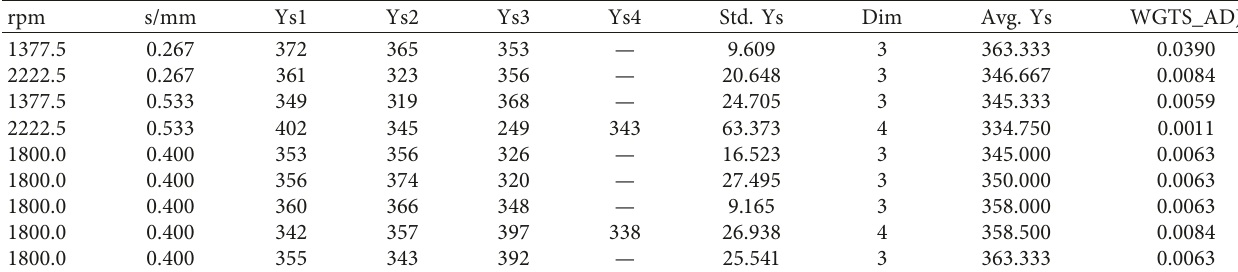
Table 2: Yield strength experimental responses.